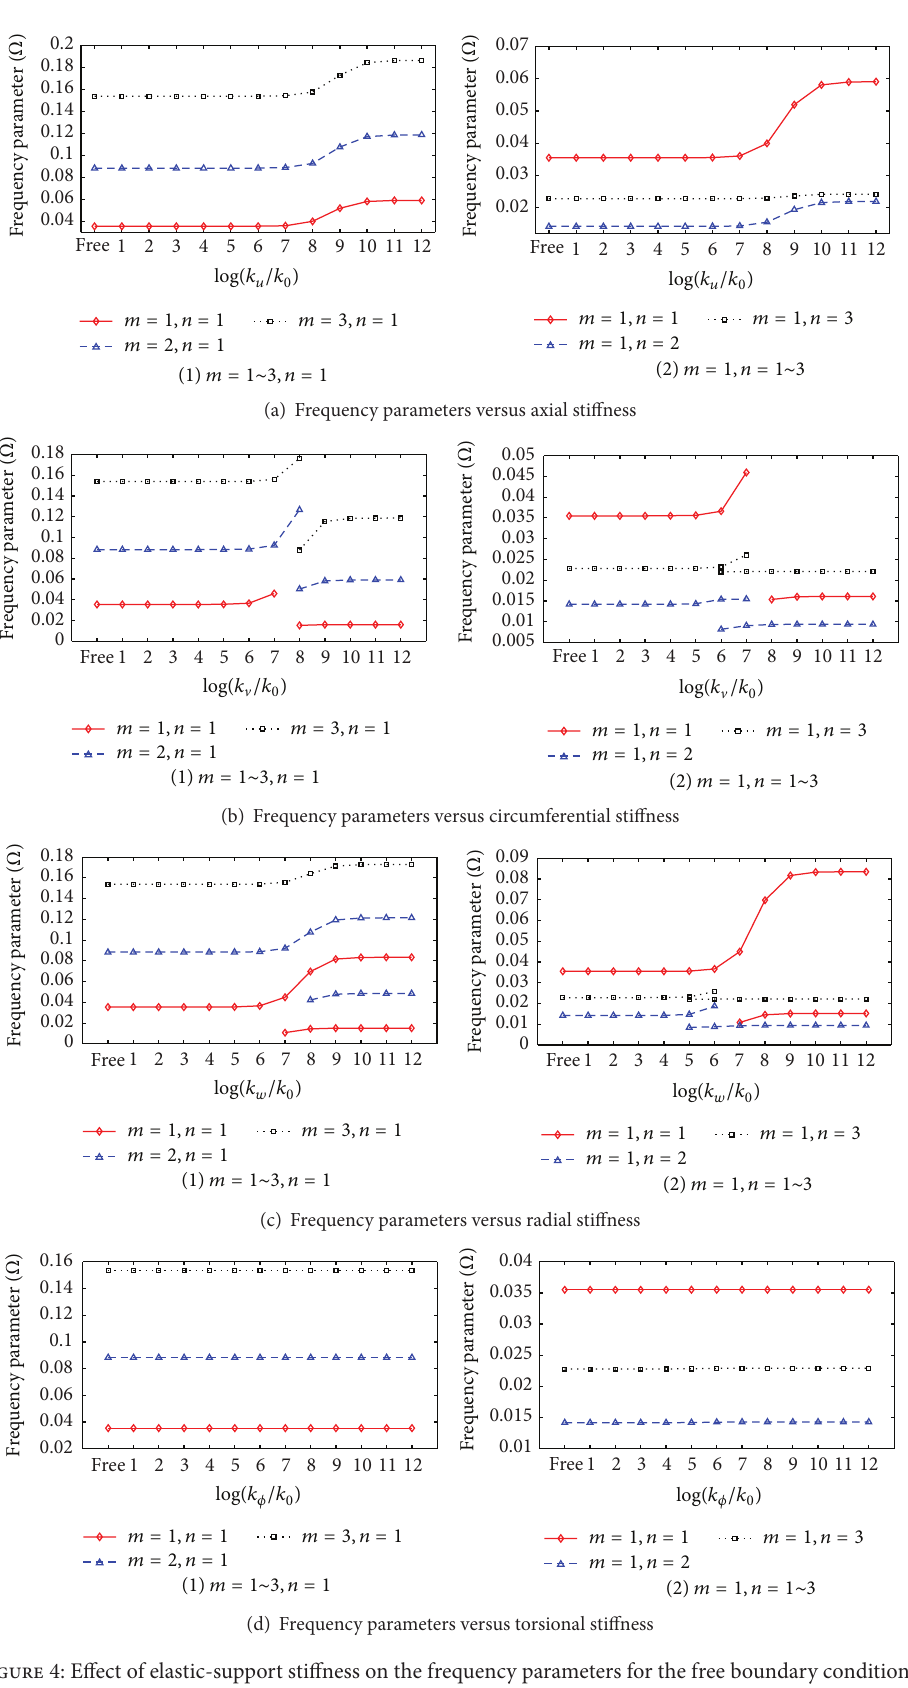
Figure 4: Effect of elastic-support stiffness on the frequency parameters for the free boundary